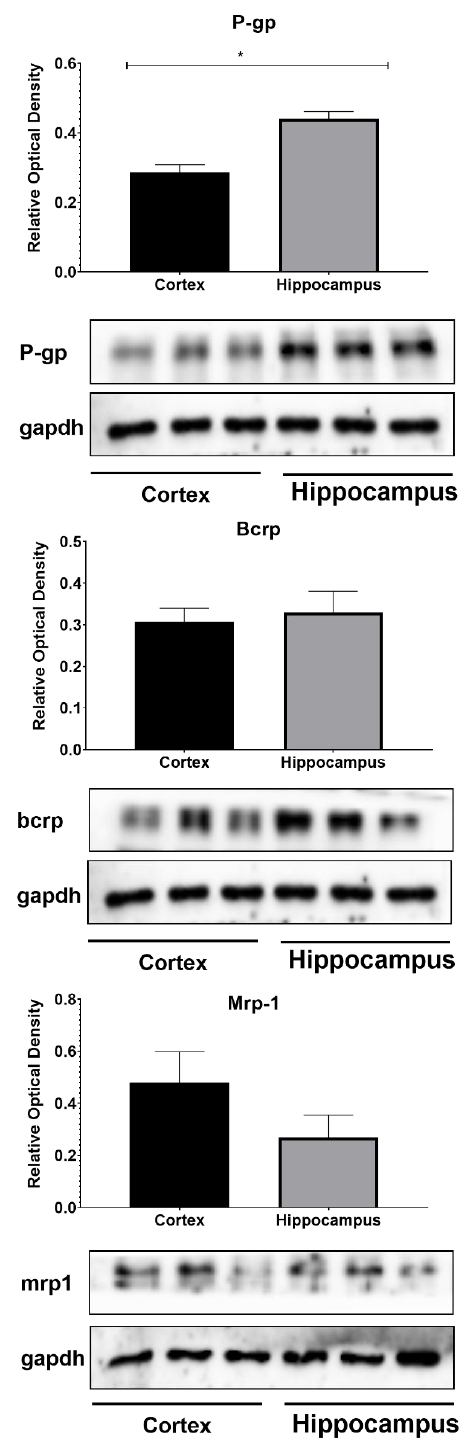
Figure 4. Levels of the ABC transporter proteins (P-gp, Bcrp, and Mrp1) in mouse brain micro vessels isolated from the cortex and the hippocampus. ( A – C ) The relative mRNA levels of abcb1a ( A ), abcg2 ( B ), and abcc1 ( C ) were assessed through real-time PCR. GAPDH was used as an internal standard. Data are represented as (2 −ΔCt ). The protein expressions of P-gp ( A ), Bcrp ( B ), and Mrp-1 ( C ) were examined using Western blot analysis. Optical densities were analyzed with Image Lab 6.0.1 software (Bio-Rad) and normalized to GAPDH. Results are the means ± SEM from three lots of brain endothelial micro vessels (each lot represents a pool from five mice). Statistical comparisons: * p < 0.05.